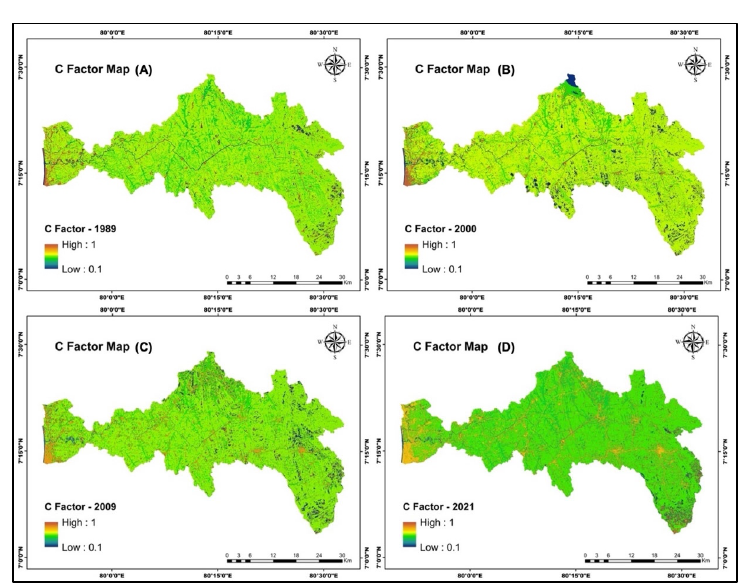
Figure A2. C factor maps of the study area for corresponding years: ( A ) 1989, ( B ) 2000, ( C ) 2009, ( D ) 2021.